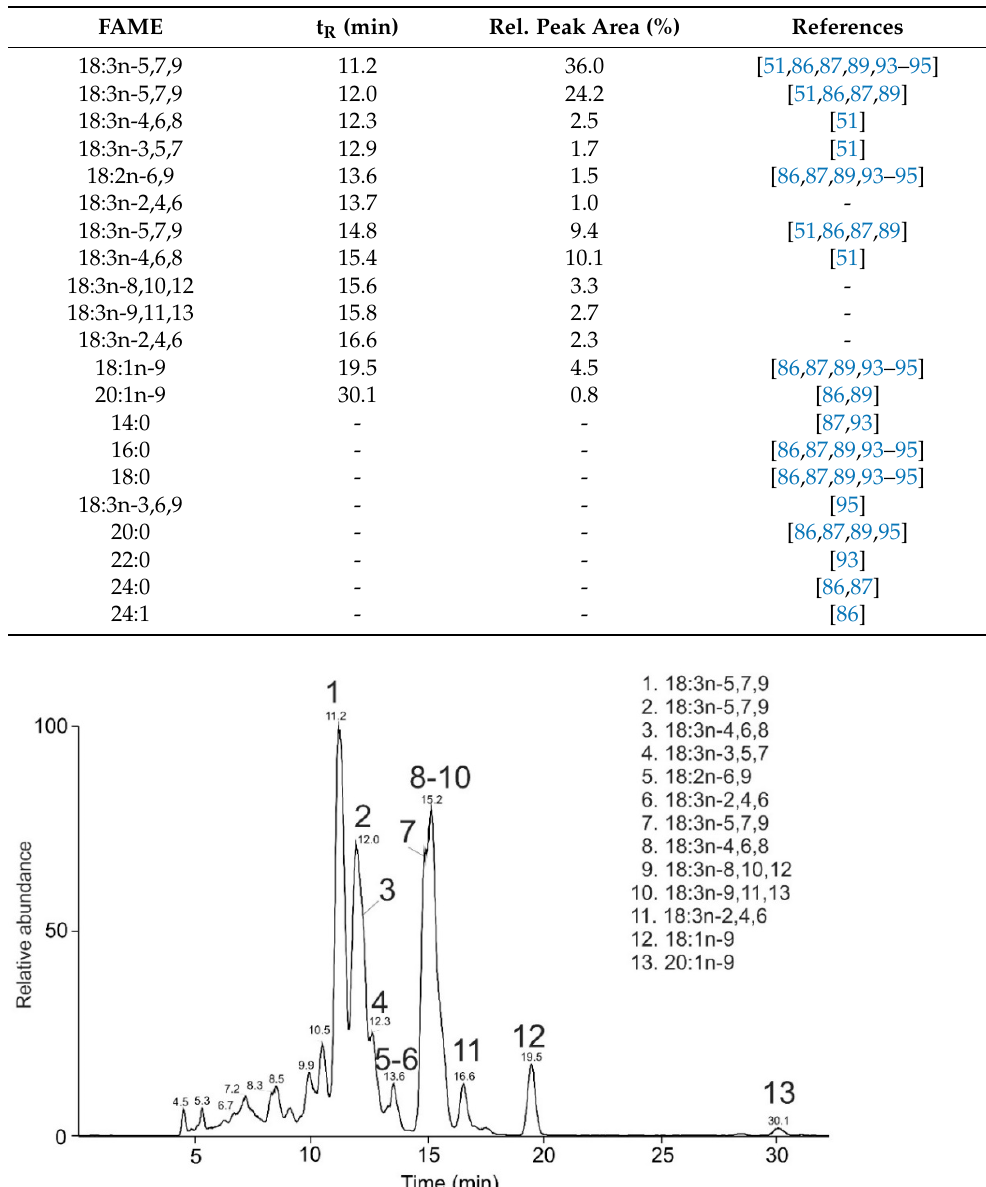
Table 3. FAMEs identified in TG fraction of pomegranate seed oil.